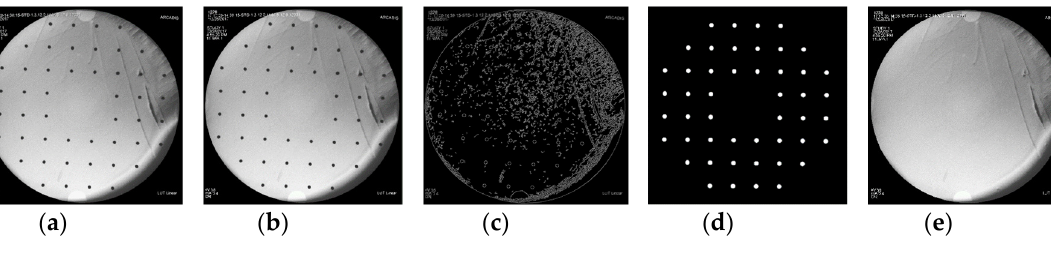
Figure 2. Procedures of image distortion correction: ( a ) Raw image; ( b ) Median filter; ( c ) Edge detection; ( d ) Target Recognition; ( e ) Inpainting image.